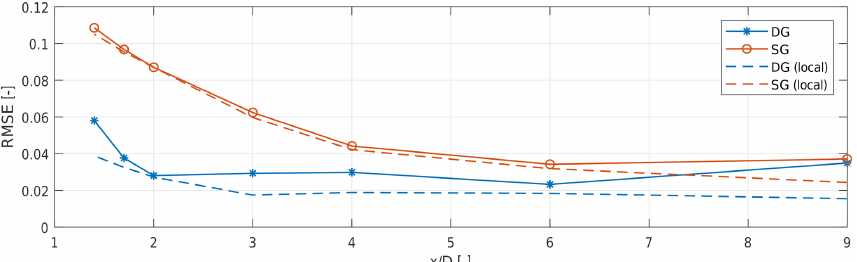
Figure 4. Root mean square error between the reference CFD velocity deficit data and the engineering wake models. Double-Gaussian (DG) wake model identified using measurements at 1.7, 3, and 6D: solid blue line with ∗ symbols. DG wake model parameterized locally at each downstream distance: dashed blue line. Single-Gaussian (SG) EPFL wake model identified using measurements at 1.7, 3, and 6D: solid red line with circles. SG EPFL wake model parameterized locally at each downstream distance: dashed red